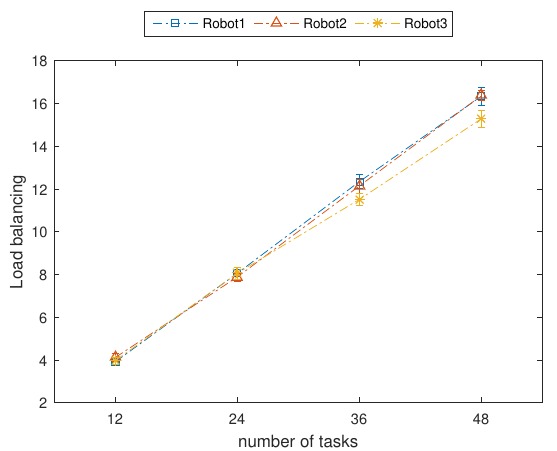
Figure 11. Average number of tasks executed per robot using an SSI auction.